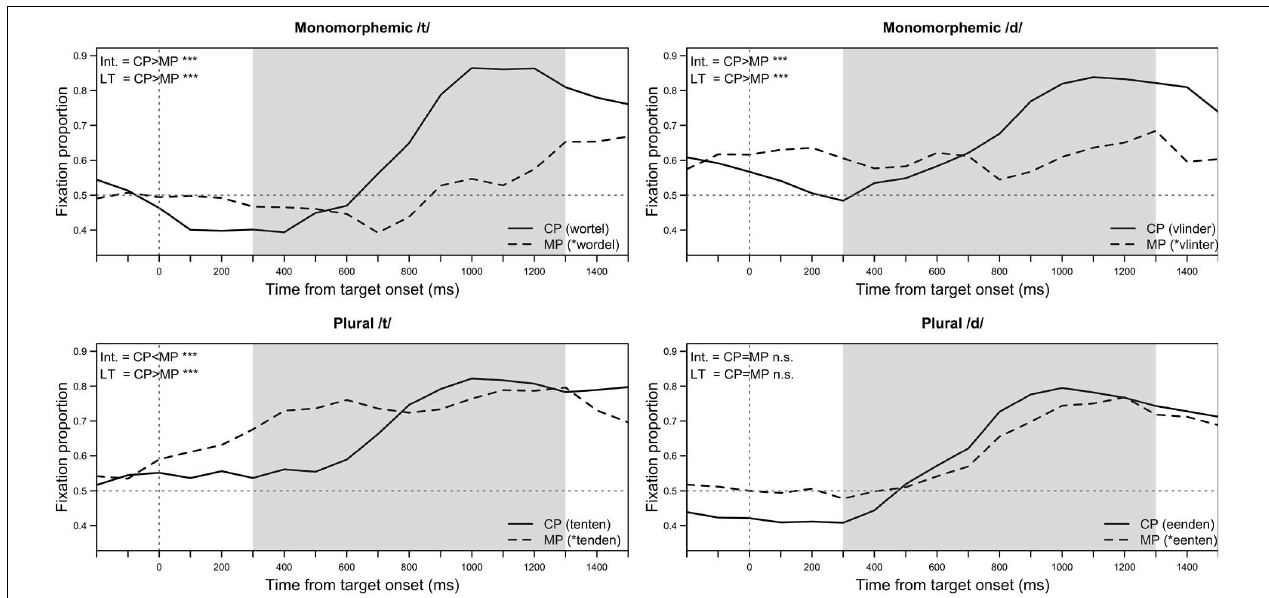
FIGURE 2 | Target fixations to different trial types in Experiment 2. Solid lines represent looking behavior when the target word was correctly pronounced (CP), and dashed lines when the target was mispronounced (MP). The shaded area corresponds to the time-window of analysis, starting 300 ms after the target word onset for a duration of 1000 ms. The abbreviations ‘Int.’ and ‘LT’ stand for ‘Intercept’ and ‘Linear Time,’ and indicate statistical differences between the height (Intercept) and gradient (Linear Time) of the two lines in each panel. These statistical differences are summarized from the pairwise comparisons presented in Table 6